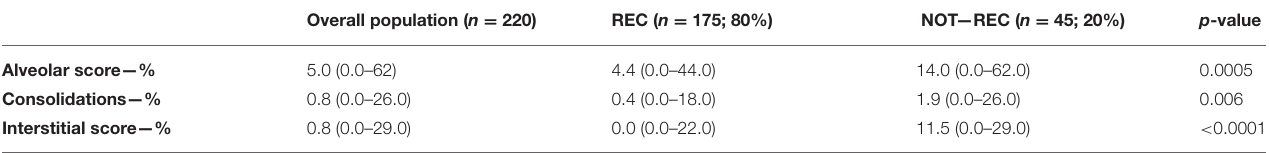
TABLE 2 | HRCT scores during hospitalization (HRCT 0 ) of the overall population evaluated at post-COVID clinic and of the two subgroups categorized according to the presence of radiological recovery during the follow-up period. Overall population ( n = 220) REC ( n = 175;